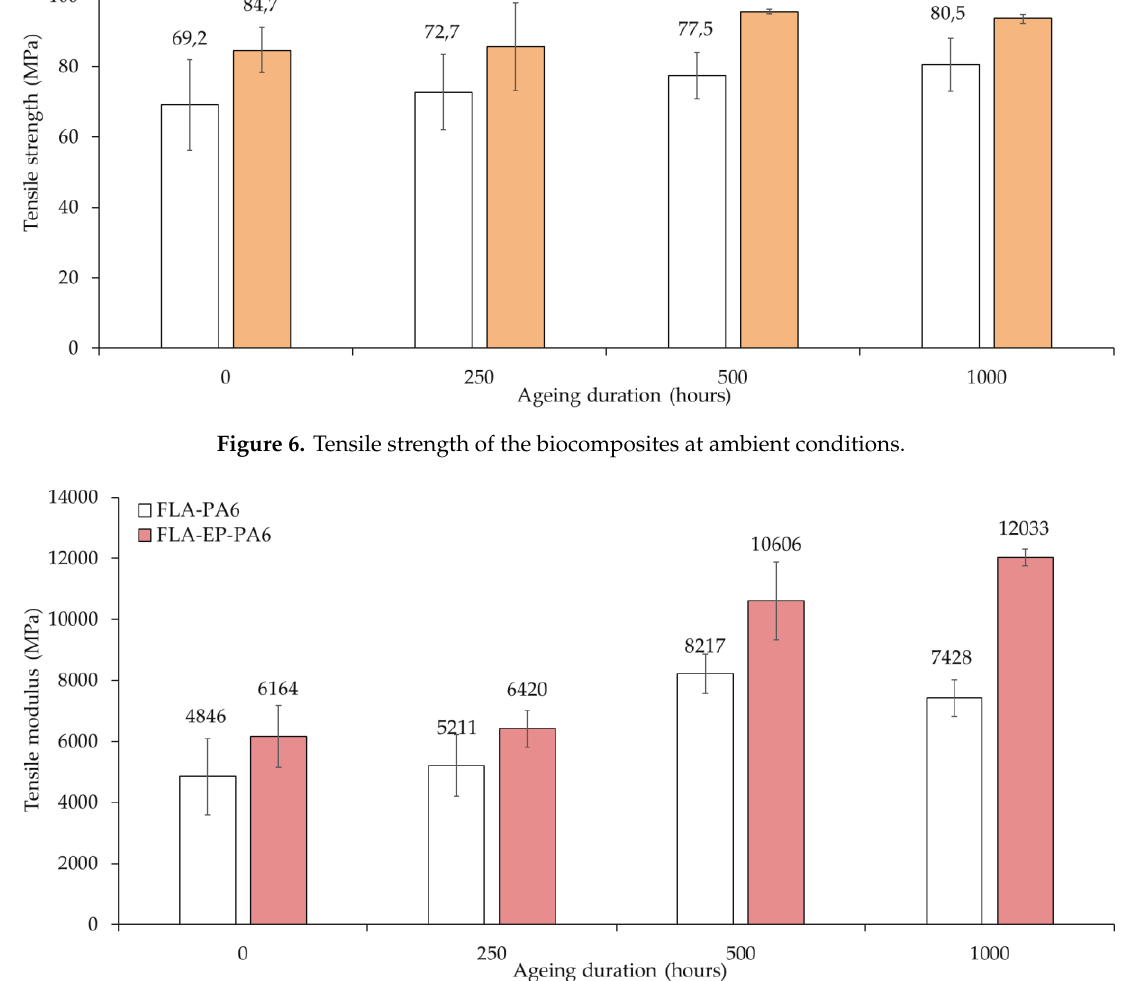
Figure 7. Tensile modulus of the biocomposites at ambient conditions.